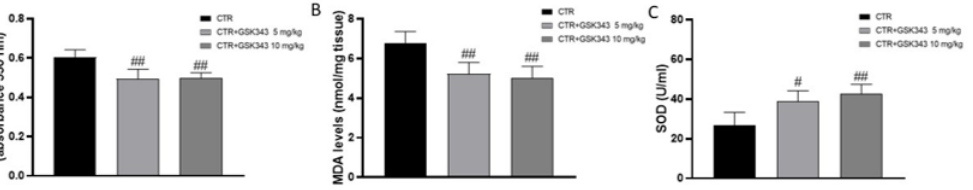
Figure 9. Effect of GSK343 on oxidative stress in U87-xenograft model. GSK343 5 mg/kg and 10 mg/kg decreased ROS, MDA, and increased SOD levels compared to the control group ( A – C ). Data are representative of at least three independent experiments. ( A ) ## p < 0.01 vs. Ctr; ( B ) ## p < 0.01 vs. Ctr; ( C ) # p < 0.05 vs. Ctr; ## p < 0.01 vs. Ctr.